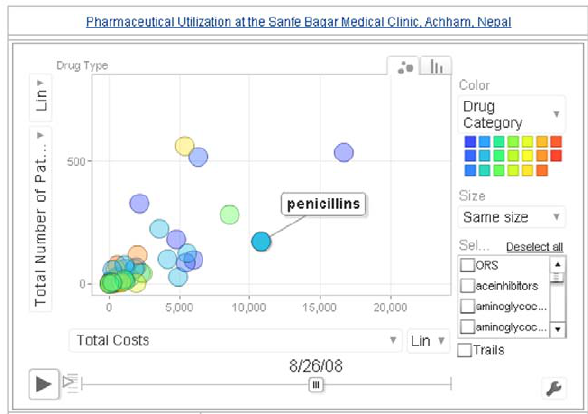
Figure 1. Screenshot of our pharmaceutical tracking system. Gapminder’s (http://www.gapminder.org) free software provides an intuitive interface for depicting utilization patterns of key pharmaceutical drugs and categories that is published regularly to the web.